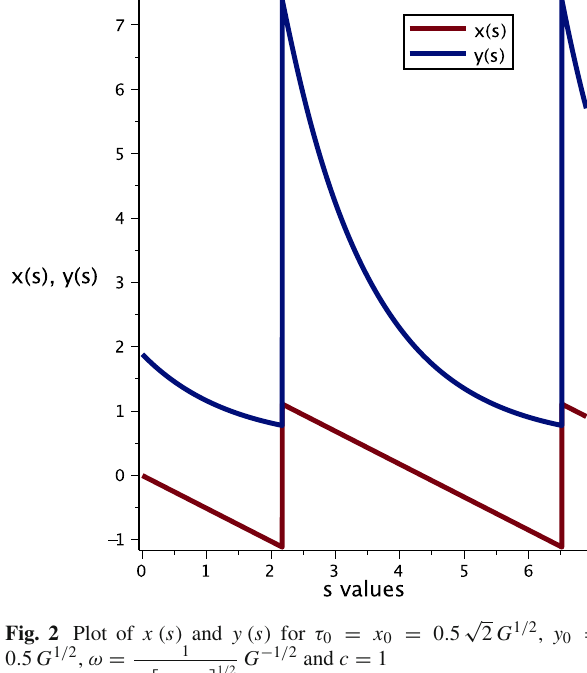
Fig. 2 Plot of x ( s ) and y ( s ) for τ 0 = x 0 = 0 . 5 0 . 5 G 1 / 2 , ω =